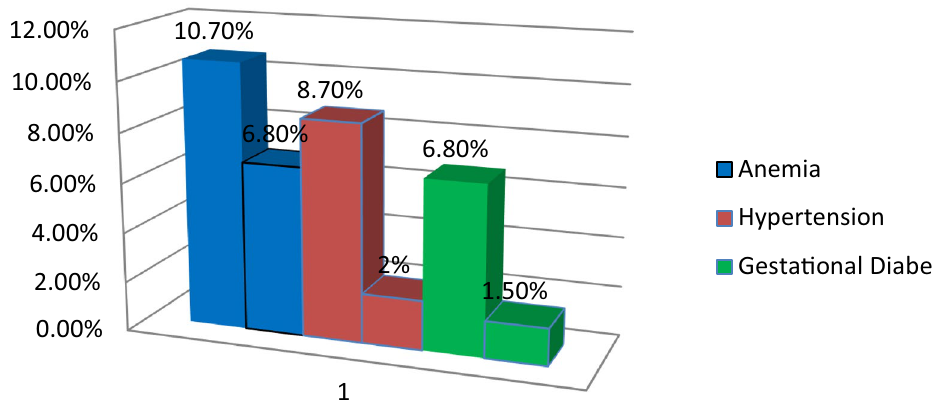
Figure 1. Medical characteristics of mothers who delivered at Ilu Aba Bor, in Public Hospitals, Ethiopia, 2021. Anemia: maternal hemoglobin level <11mg/dl, both pregnancy induced and chronic hypertensive.